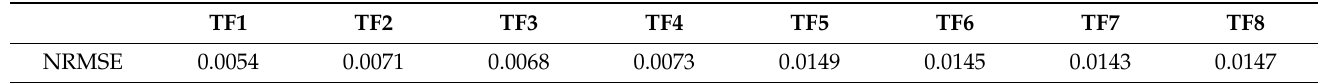
Figure 7. The results of the second controller experiment: ( a) and ( c ) representing both the input values of the controller experiment as well as the reference experiment for TF1 and TF6, respectively; ( b) and ( d ) representing both the output measurements of the controller experiment as well as the reference experiment for TF1 and TF6, respectively. Table 9. NRMSE values comparing the accumulated lactate output values of the controller experi- ment two with the trajectory values using the goodnessOfFit function in MATLAB. The NRMSE closer to zero represents the better fit.